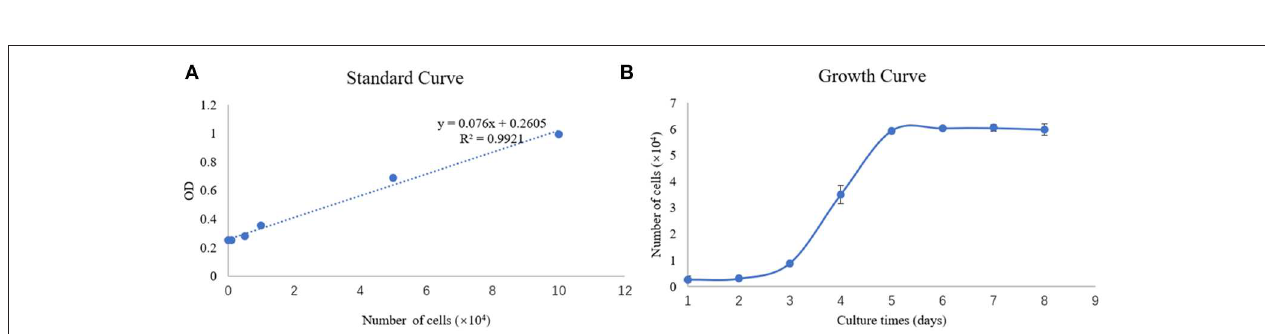
FIGURE 2 | The identification of SEECs by CK18. (A) Cells incubating with CK18 and secondary antibody. (B) Cells incubating with PBS and secondary antibody (magnification × 200).